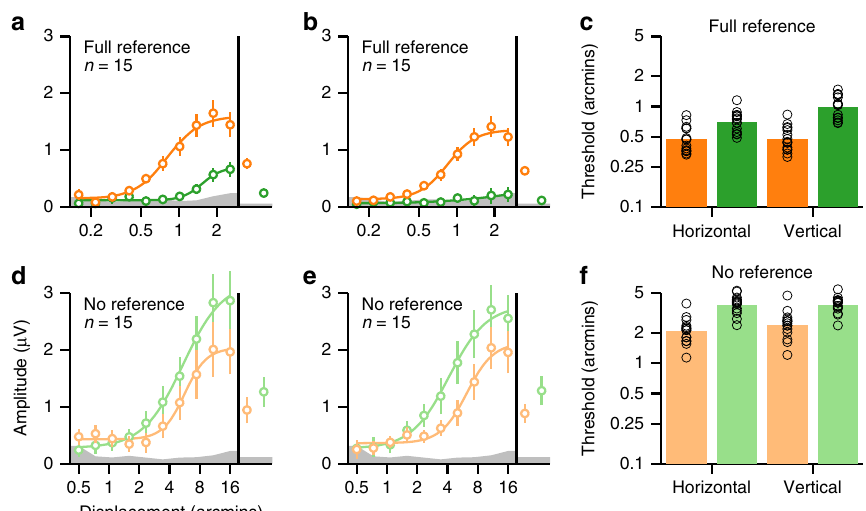
Fig. 3 Adult second harmonic SSVEP response functions and psychophysical detection thresholds. a , b SSVEP data from horizontal and vertical full-cue/ full-reference ( n = 15). In-phase conditions are plotted in orange and anti-phase conditions in green. We ran both descending and ascending displacement sweeps; response functions are averages over ascending and fl ipped versions of descending trials. As in Fig. 2, averages across all displacements are shown on the right side of the response functions, gray bands represent the average background EEG noise, and smooth curves are Naka – Rushton fi ts to the data. Responses were weaker for anti-phase compared to in-phase for both horizontal and vertical motion. c Psychophysical thresholds for in-phase (orange) and anti-phase (green) conditions for horizontal and vertical directions of motion, plotted on a log scale, and again averaged over ascending and descending sweeps. Individual participant thresholds are plotted as circles overlaid on the bars. Thresholds were higher for anti-phase compared to in- phase motion. d , e SSVEP data for no-reference conditions ( n = 15). Note that a larger range of displacements was used for the no-reference conditions and that the response functions depart from the noise level at higher displacements than in the full-reference conditions. Unlike the referenced conditions, responses are weaker for in-phase compared to anti-phase. f Psychophysical thresholds for the no-reference condition. Overall psychophysical thresholds are higher by a factor of ~4.7 than for the full-reference conditions and thresholds are higher for anti-phase than in-phase motion for both orientations. Error bars are on the SSVEP data are ±1